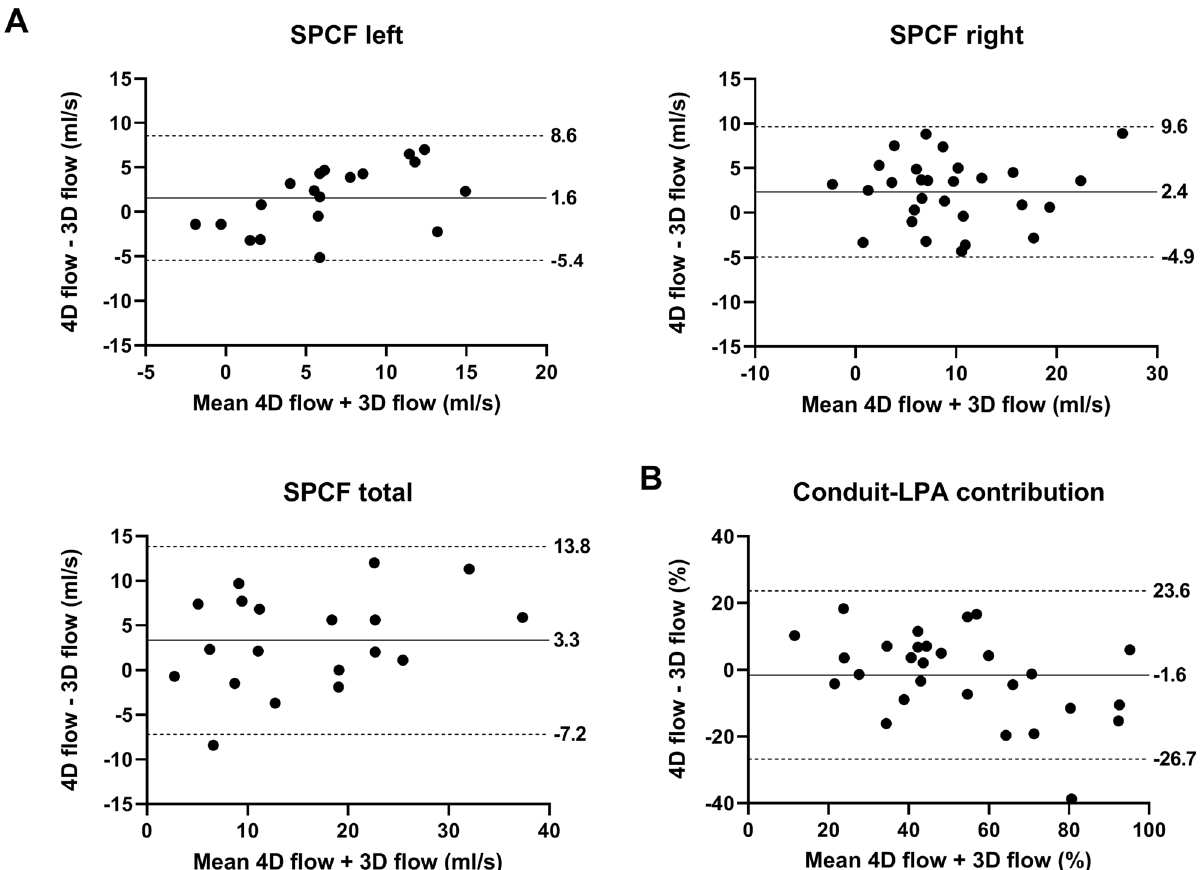
Figure 3. Bland–Altman plots comparing left, right and total SPCF ( A ) and conduit-LPA contribution ( B ) between 4D and 3D flow. Mean bias and limits of agreement are shown. LPA; left pulmonary artery, SPCF; systemic-to-pulmonary collateral